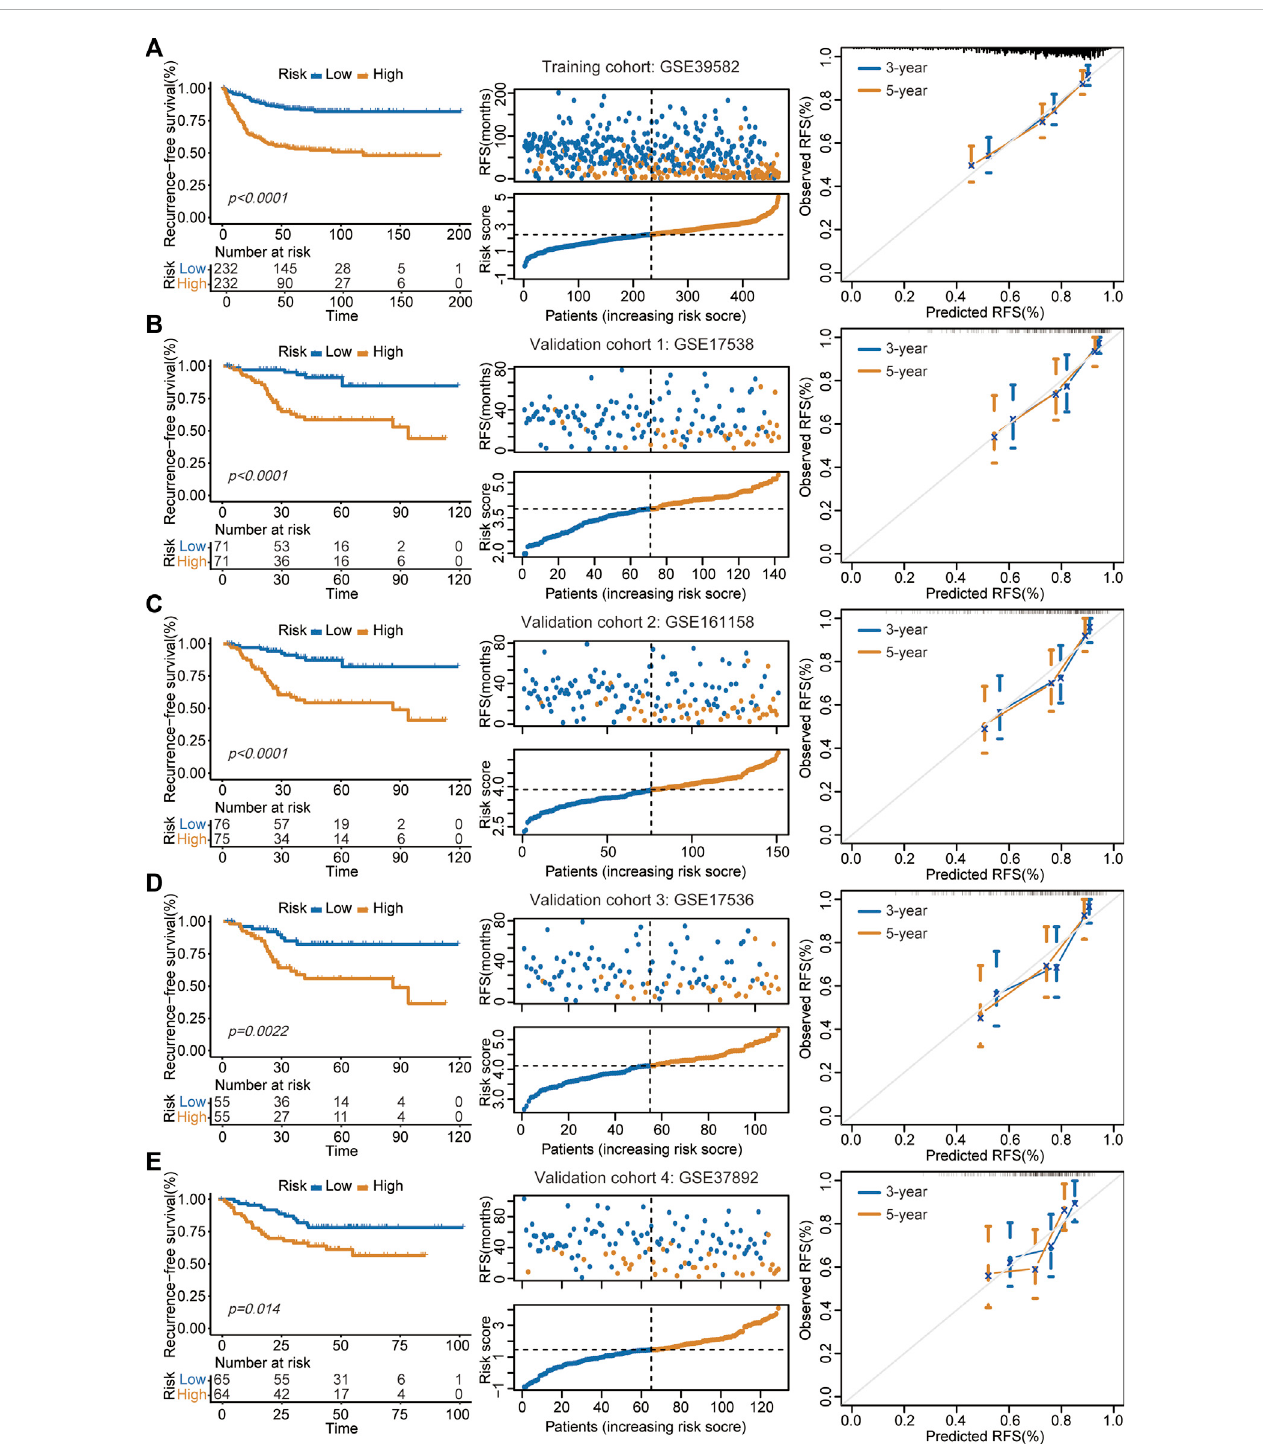
FIGURE 2 Assessment of prognostic performance in training and validation cohorts. (A – E) The proposed signature precisely captured the survival differences between two risk groups in GSE39582 (A) , GSE17538 (B) , GSE161158 (C) , GSE17536 (D) , and GSE37892 (E) cohorts, respectively. Left panel: K-M curves estimated the RFS differences between two risk groups. Middle panel: From top to bottom was the distribution of survival status and risk scores. The orange dots represented recurrence while the blue dots represented non-recurrence. Right panel: Calibration curves for the 9-gene